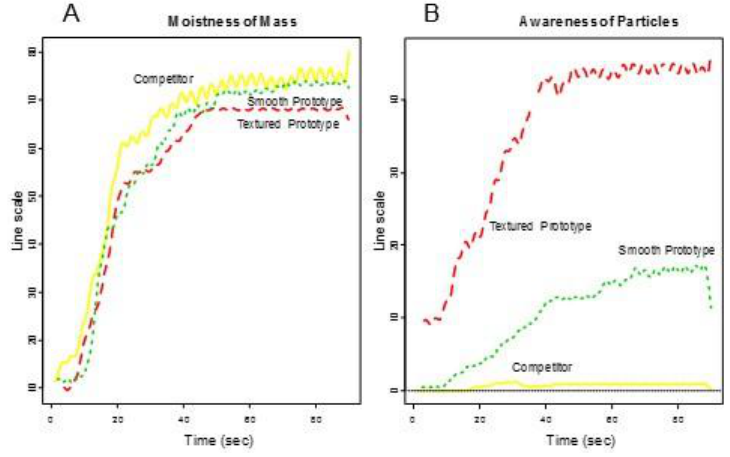
Figure 3. Descriptive panel chew-down ( A ) Hardness and ( B ) Cohesiveness.